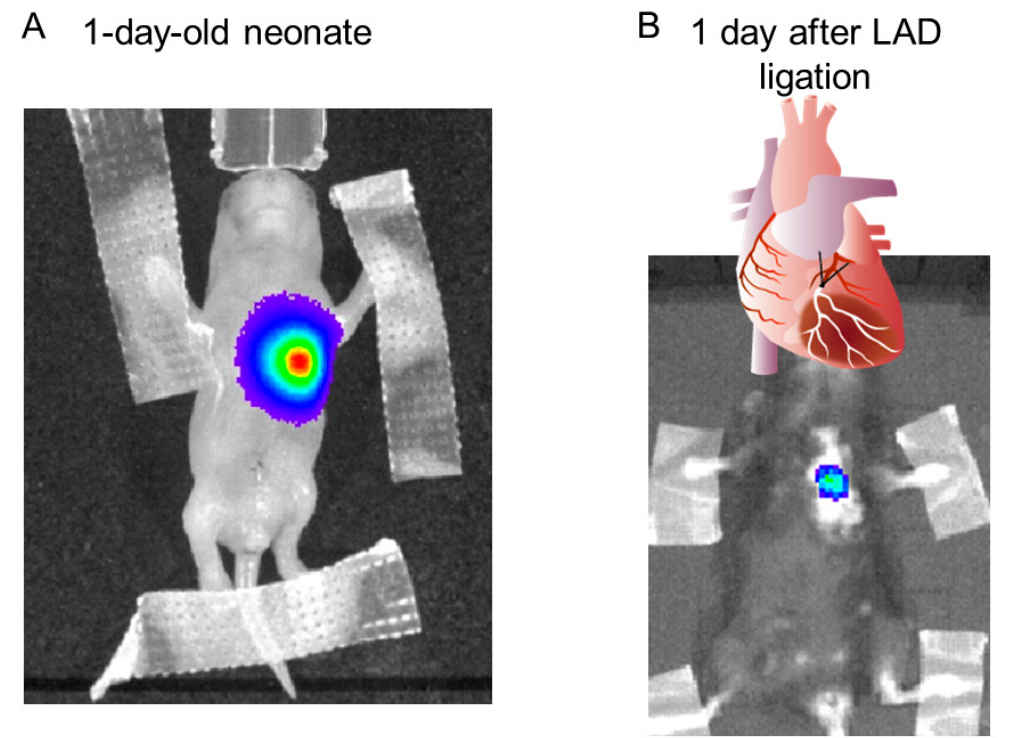
Figure 2. ( A ) Detection of luciferase activity in one-day BNP reporter mouse. ( B ) Detection of luciferase activity in reporter mouse one day after ligation of the left anterior descending coronary artery (LAD). BNP, brain natriuretic peptide.